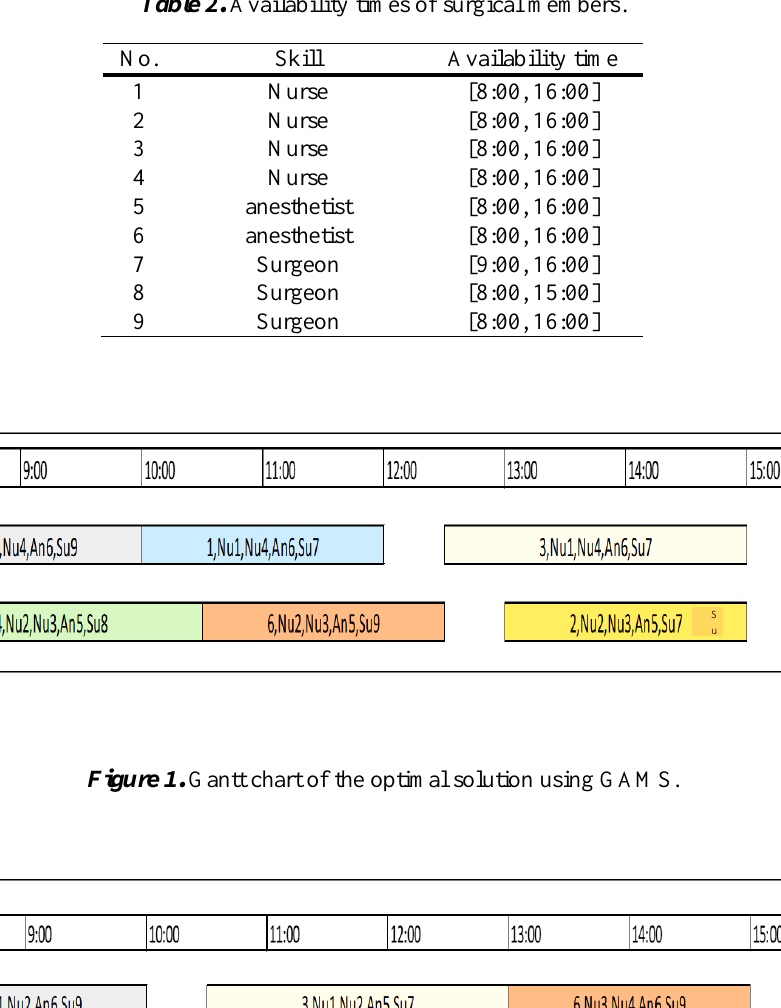
Table 2. Availability times of surgical members.